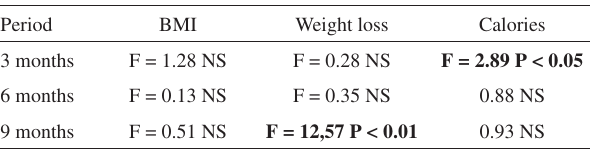
Table 2 - Nutritional impact of daily meal frequency (ANOVA